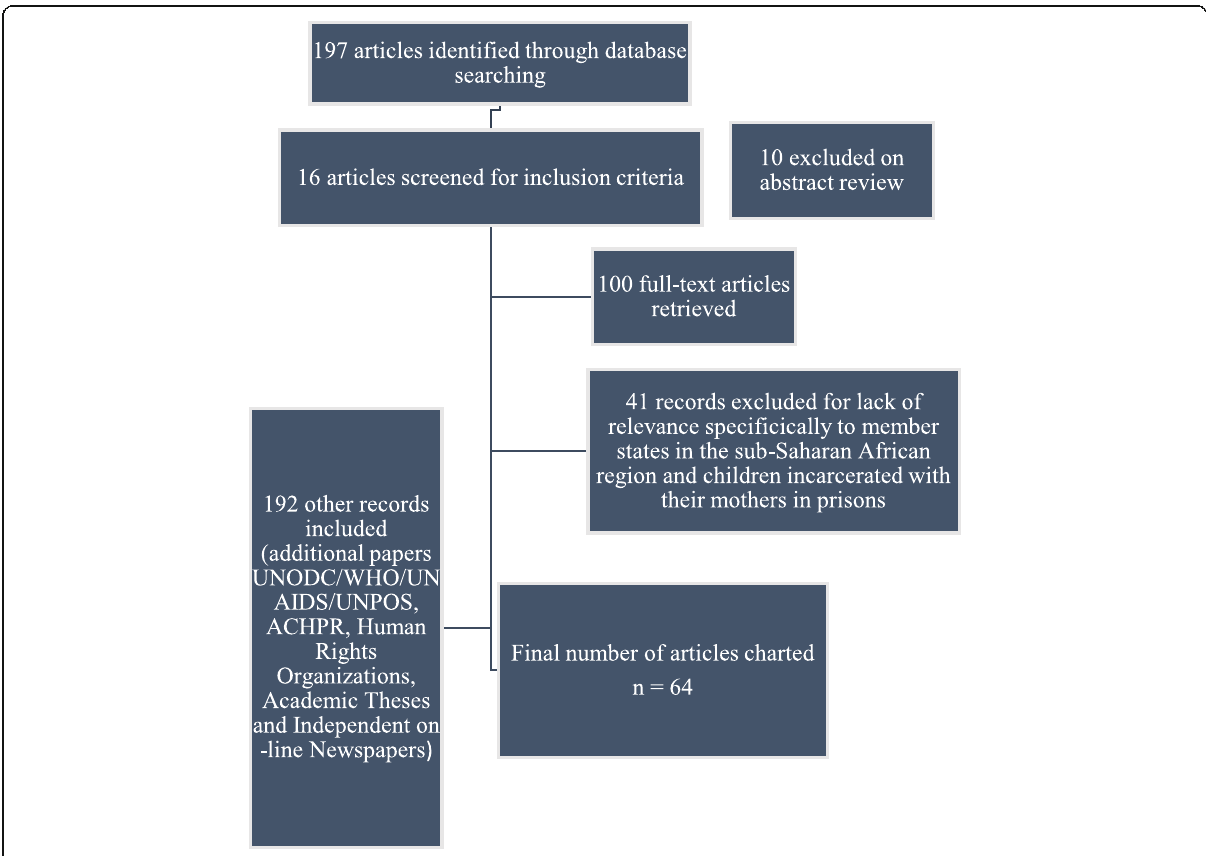
Fig. 1 ‘ Flowchart for inclusion and exclusion of literature